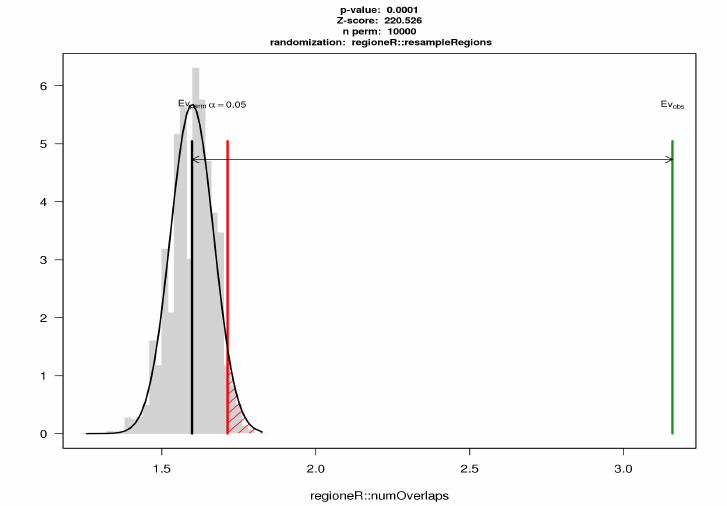
Figure 3. Numbers of sign-consistent overlapping DMCs between Model I and Model V generated by permutation analysis using regioneR. The X-axis represents the number of overlapping sites on a log10 scale, and the Y-axis specifies the probability density so that the histogram has a total area of one. The black curve on the left side shows the estimated null distribution, from 10,000 permutations, for the number of overlapping sites when significant DMCs for ACPA and RA are randomly selected from the 2,106,243 CpGs tested in both analyses and showing same direction of effect. The red vertical line denotes the 0.05 significance threshold for p -values. The green line on the right side shows the observed number of overlapping DMCs (1441) with same direction of effect, which is much larger than any of the 10,000